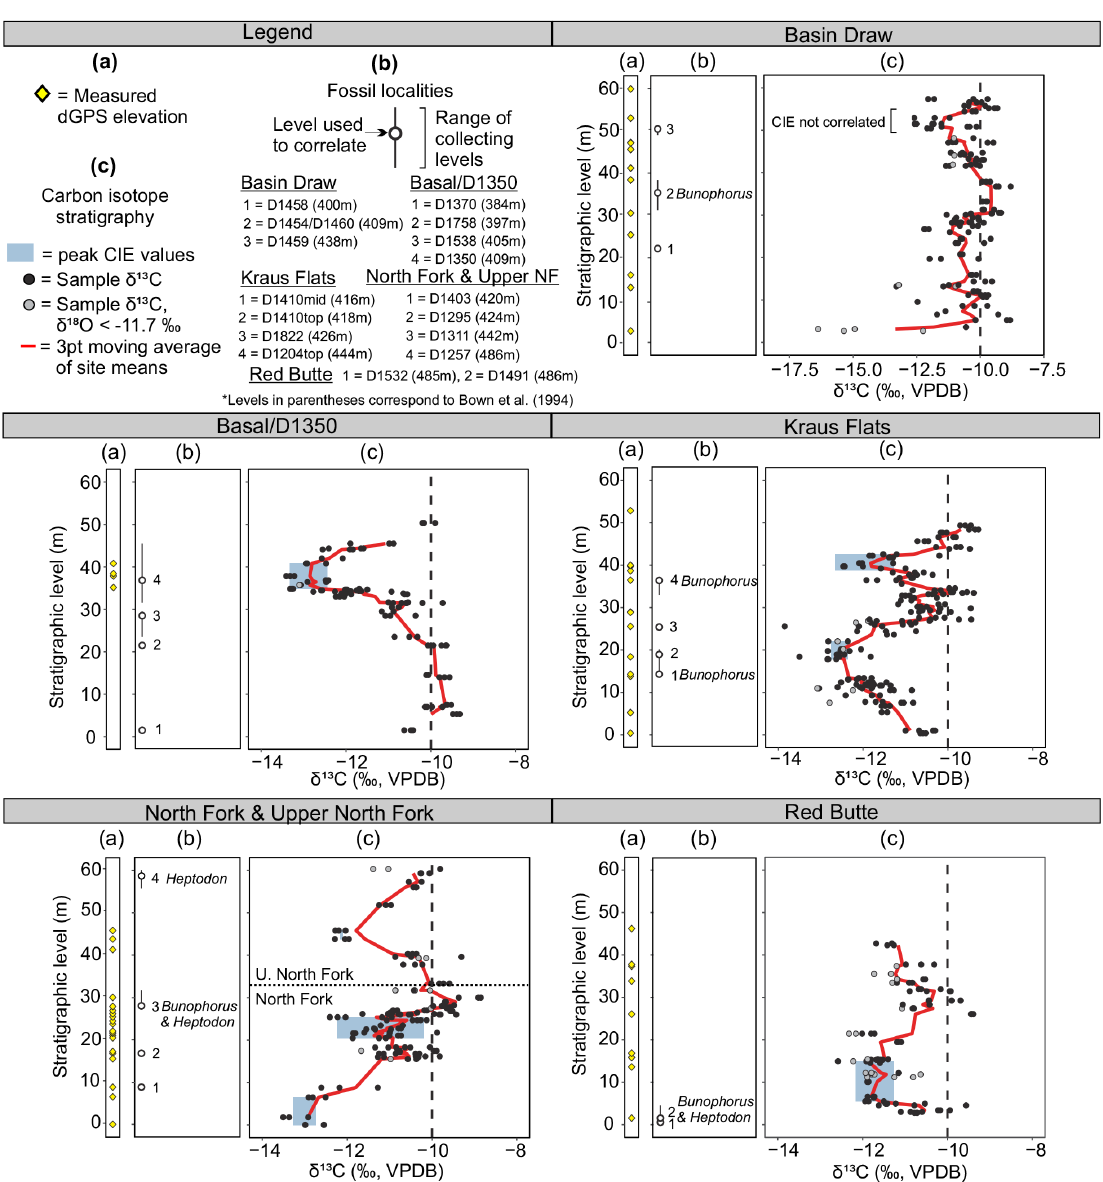
Figure 3. Carbon isotope data from pedogenic carbonate nodules for Fifteenmile Creek sections. (a) Stratigraphic levels at which dGPS elevations were collected. (b) Fossil localities that were sampled within the section. Open points correspond to the Bown et al. (1994) composite meter level for the locality and main collecting level. Lines show ranges of collecting levels. Fossil localities with Bunophorus are Wa5 or above. Localities with Heptodon are Wa6 or above. (c) Carbon isotope stratigraphy. Points represent measurements for individual nodules (black: δ 18 O > − 11 . 7‰, grey: δ 18 O < − 11 . 7‰). Red lines are a three-point moving average through the mean values from a sampling site, and blue shading shows the range of peak values used to calculate CIE magnitudes. Note that the CIE at ∼ 45m in the North Fork and Upper North Fork sections includes a small range of ∼ − 12‰ values, making the blue shading there difficult to see. Black dashed lines at − 10‰ show the typical background value for Fifteenmile